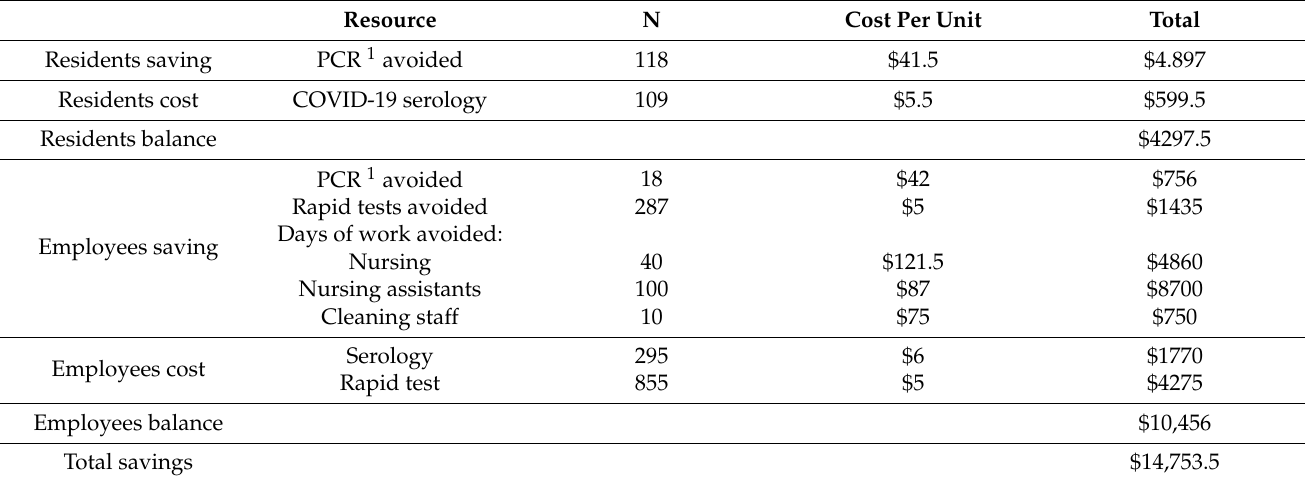
Table 3. Financial